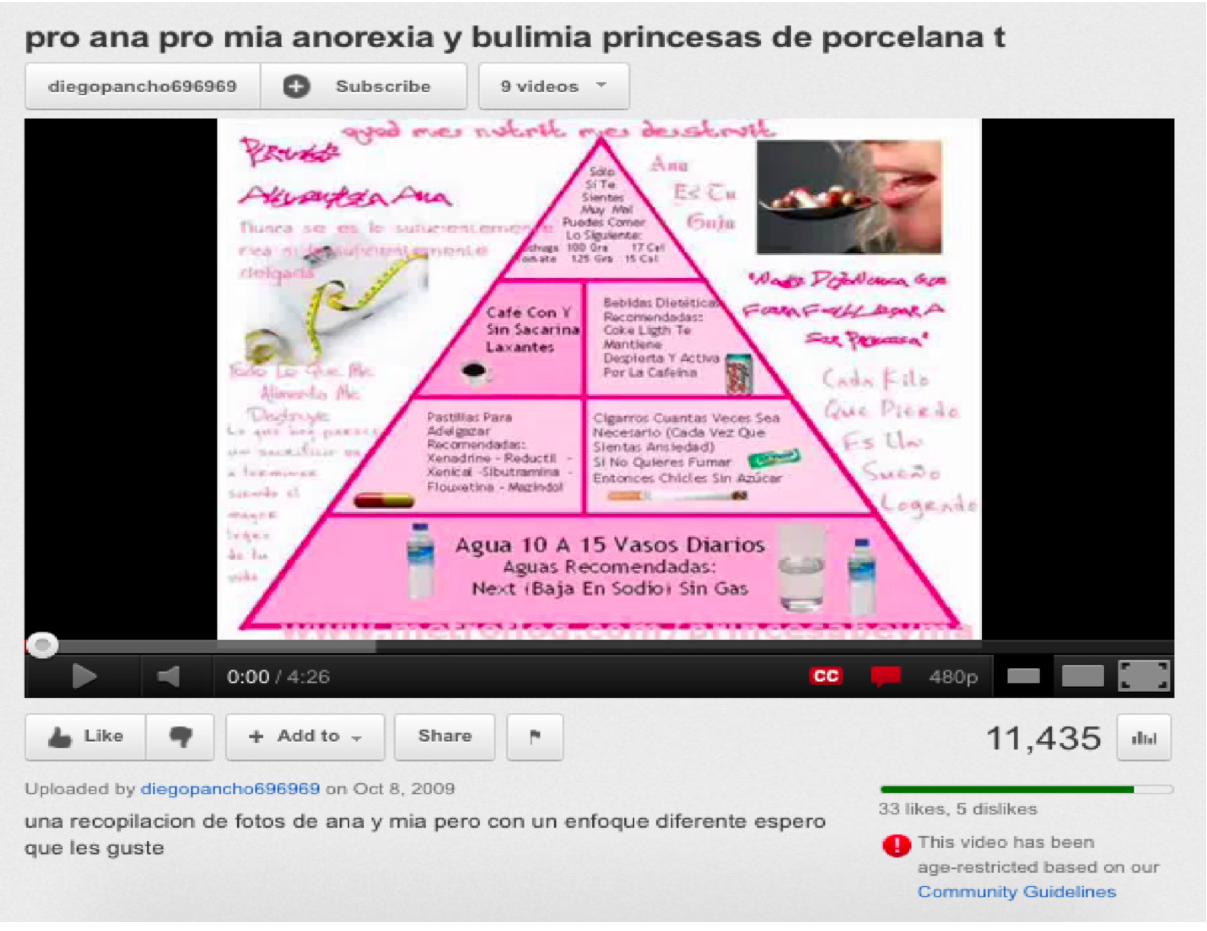
Figure 3. Screenshot of a Spanish video promoting anorexia through drugs and